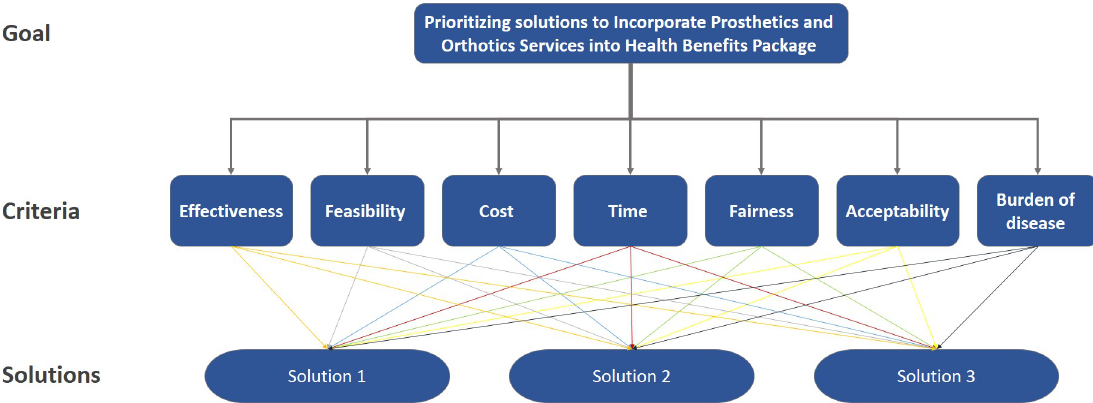
Fig 2. An analytic hierarchy process of final goal, desirable criteria, and potential